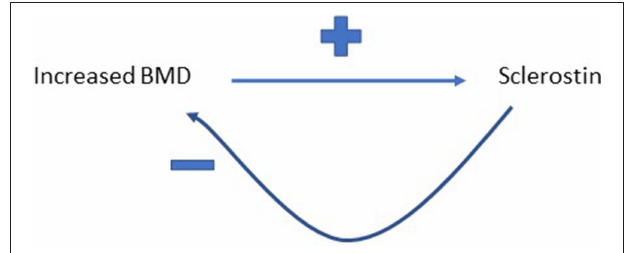
FIGURE 3 | Proposed feedback pathway between BMD and sclerostin. Greater BMD is proposed to increase circulating levels of sclerostin, which then feeds back to inhibit bone formation, and hence limit further gains in